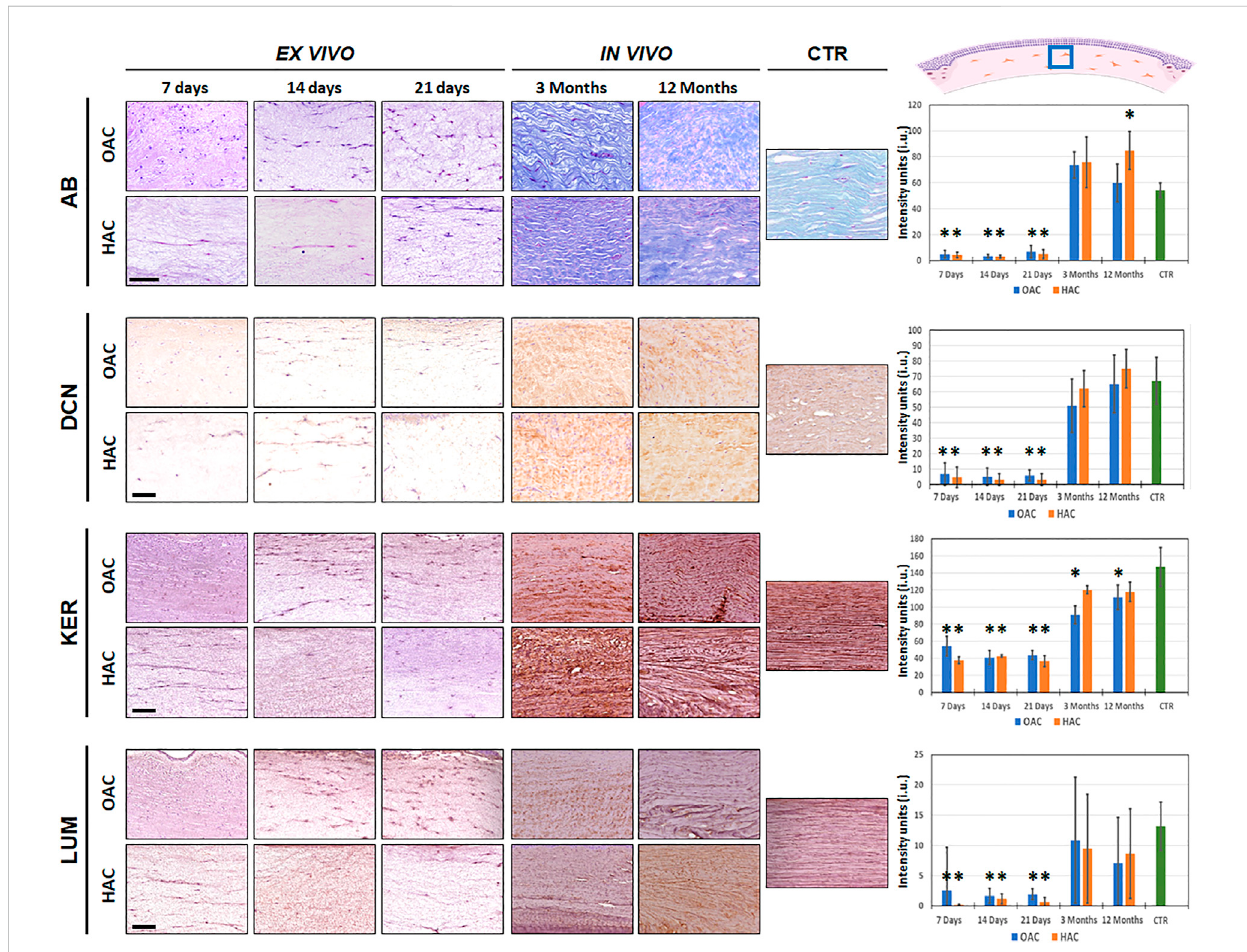
FIGURE 4 Identi fi cation of non- fi brillar components of the corneal stroma of orthotypical (OAC) and heterotypical (HAC) arti fi cial corneas and controls. AB: alcian histochemistry for global proteoglycan detection; DCN, KER and LUM: immunohistochemical detection of the proteoglycans decorin, keratocan and lumican, respectively. The area inwhichthe invivo histological images were obtained islabeled with ablue square inthe illustrationrepresenting the rabbitcorneashownattheupperrightcorner.Bioarti fi cialcorneaskept exvivo for7,14and21 days,andcorneasgrafted invivo for3and12 months areshown. Controls(CTR)correspondtonative,normalhuman corneas.Scalebars:50 µm(applicabletoallimages).Histogramstotherightcorrespond to the quantitative analysis of signal intensity quanti fi ed in intensity units (i.u.) of the ImageJ software. Asterisks represent statistically signi fi cant differences as compared to CTR